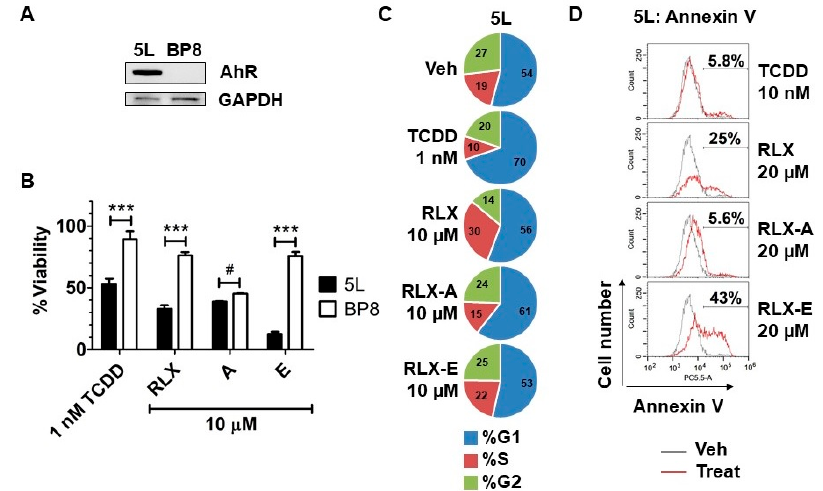
Figure 4. Inhibition of hepatoma cell viability by raloxifene analogs. ( A ) Western blot showing the relative AhR expression in 5L and BP8 cells. ( B ) 5L and BP8 cells were treated with the compounds as indicated, or with 0.1% DMSO for 72 h. Cell viability of the vehicle control was set to 100% and the relative viability is shown as the mean ± SEM ( n = 3). Two-way ANOVA and Bonferroni post-test were performed to analyze the data for statistical significance ***, p < 0.001; #, not significant ( C ) Cell cycle analysis of 5L cells treated with vehicle, 1 nM TCDD, 10 µ M raloxifene, 10 µ M analog A, or 10 µ M analog E for 48 h. ( D ) Apoptosis analysis by flow cytometry. Annexin V staining of 5L cells after 24 h treatment with vehicle, 10 nM TCDD, 20 µ M raloxifene, 20 µ M analog A, 20 µ M analog E. The Annexin V positive population is presented as a percent ratio minus the vehicle control, which was 5.1%.